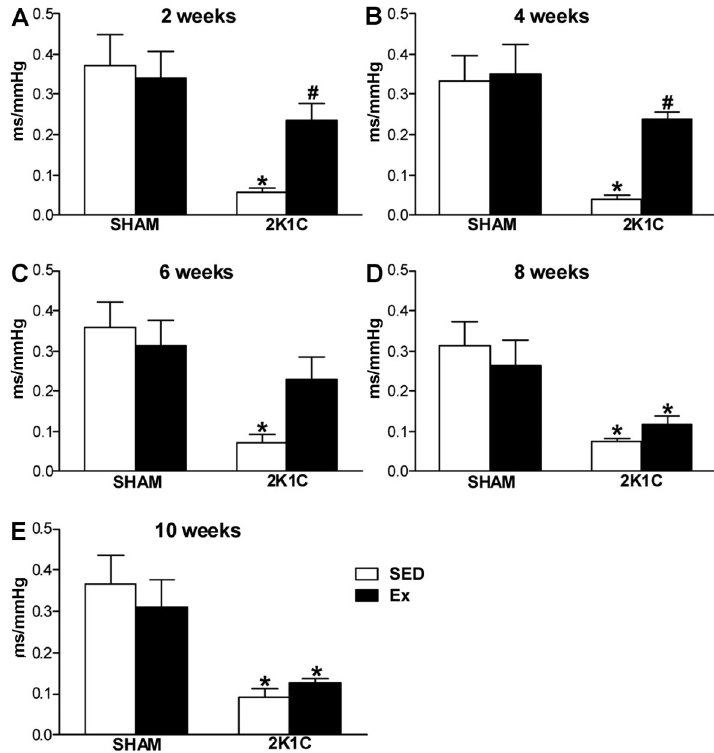
Figure 2. Index of the sensitivity of barore fl ex bradycardia (ms/mmHg) induced by injection of phenylephrine (4.0 mg, iv ) in normotensive (SHAM, n=5 – 8) and hypertensive rats (2K1C, n=5 – 8), either sedentary (SED) or subjected to physical exercise training (Ex), at 2 ( A ), 4 ( B ), 6 ( C ), 8 ( D ), and 10 weeks ( E ) of swimming. *P o 0.05 com- pared to SHAM SED rats. # P o 0.05 compared to 2K1C SED rats (two-way ANOVA followed by Bonferroni